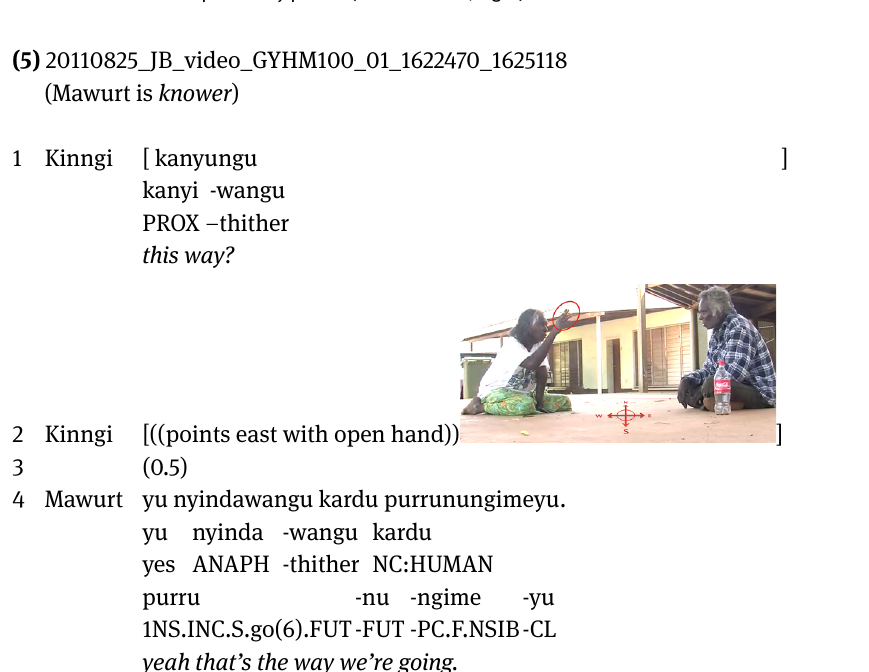
Figure 6: Total counts of demonstrative type tokens attested in the dataset (solid bars, left) vs. counts on the subsets of those tokens that are accompanied by points (hatched bars,